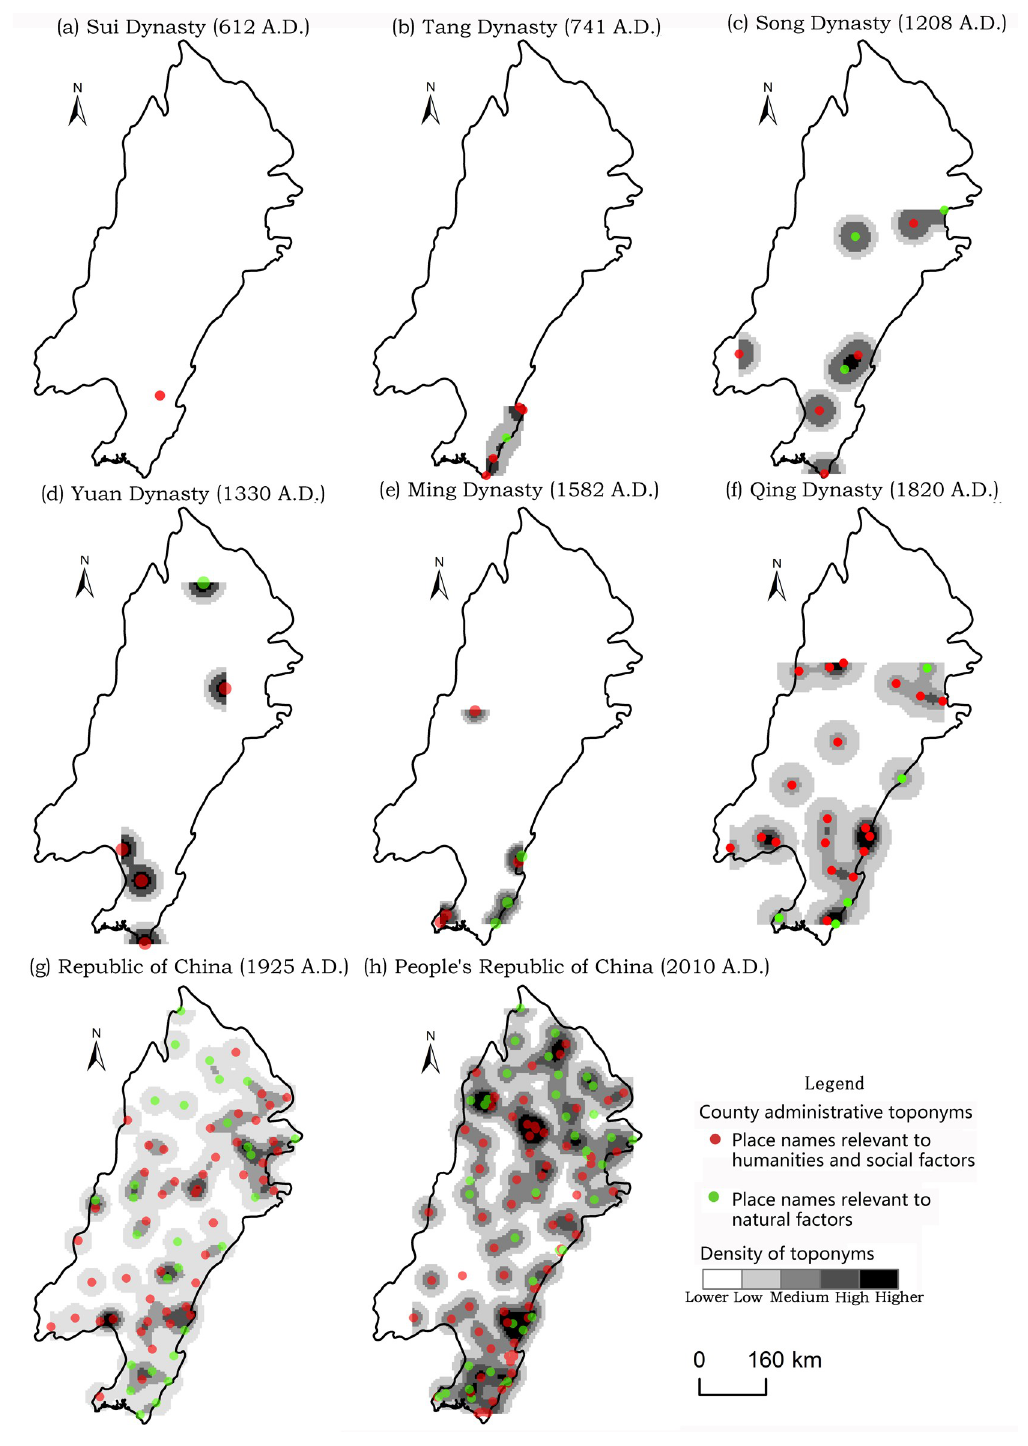
Fig 4. Spatio-temporal evolution of county-level administrative toponyms in the Northeast China Plain since the Sui dynasty.